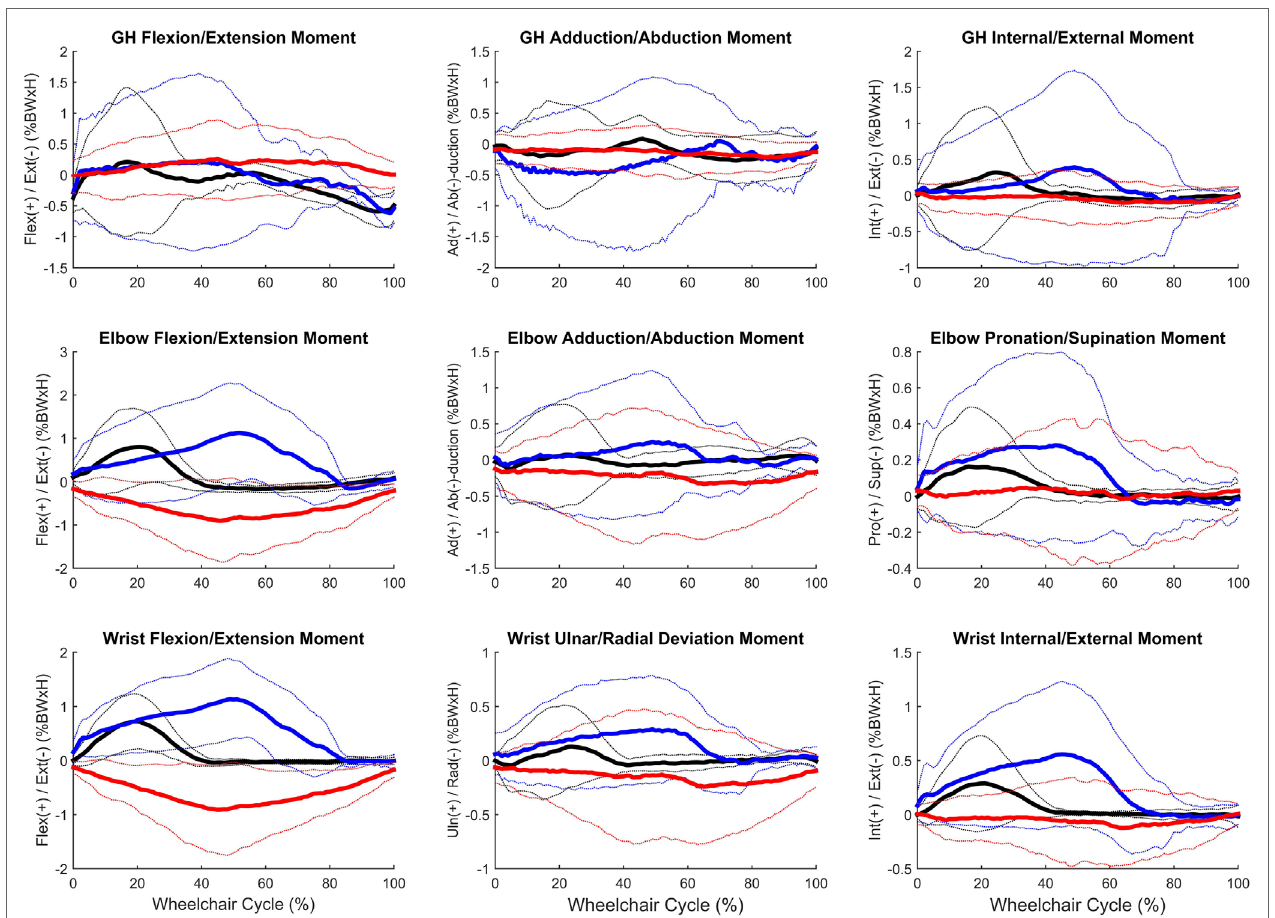
FigUre 9 | group mean (bold) and ± 1 sD for the glenohumeral joint moments (top row), elbow joint moments (middle row), and wrist joint moments (bottom row) during the steady-state propulsion (black), start stroke (blue), and stopping stroke (red) . All moments are normalized to percentage of body weight multiplied by height (% BW ×